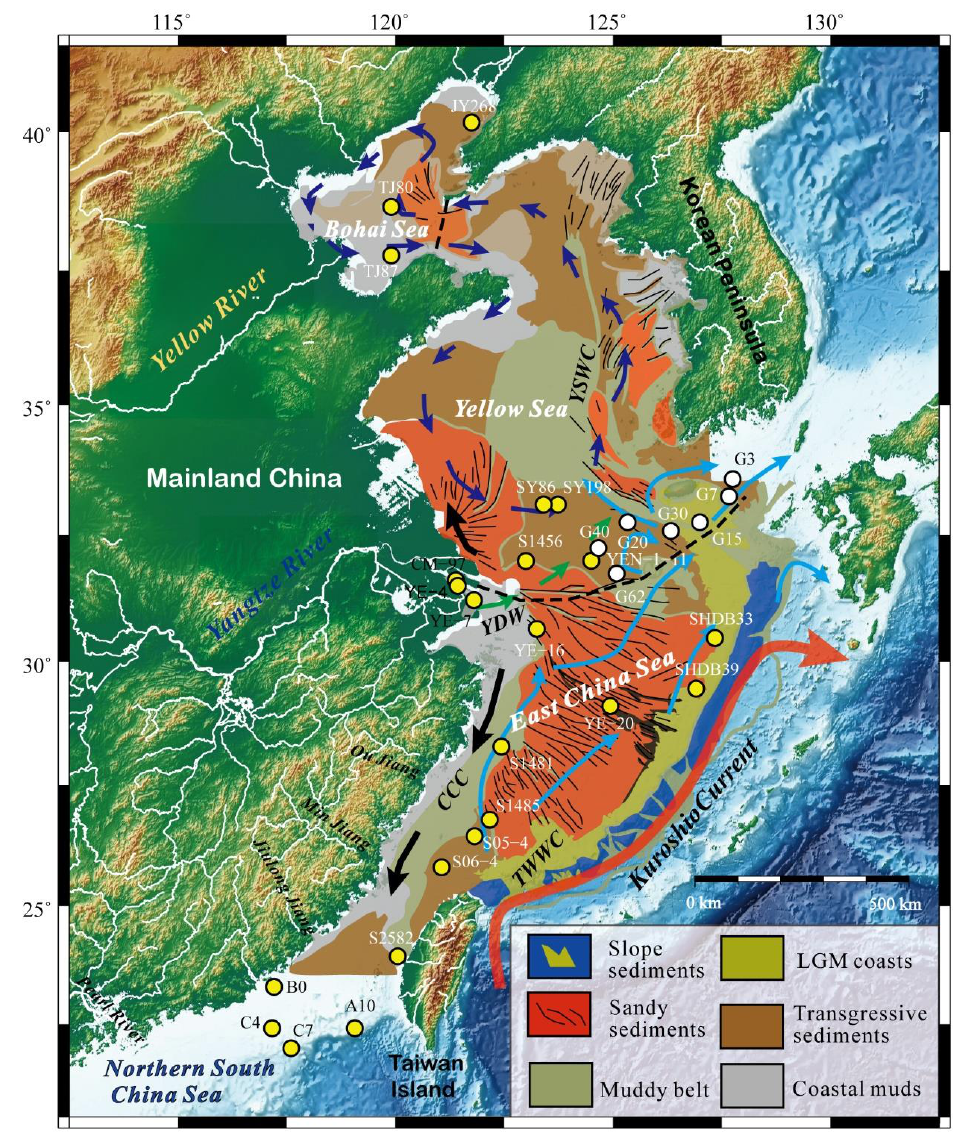
Figure 1. Map showing surface sediment types, ocean currents and sampling sites in the east China seas. The surface sediment distribution and ocean currents are from the literature [30,31], respectively. Ocean currents are denoted by solid lines with different colors (red: Kuroshio Current; light blue: Taiwan Warm Current (TWWC); black: China Coast Current (CCC); green: Yangtze Diluted Water (YDW); dark blue: Yellow Sea Warm Current (YSWC)). Circles filled by yellow are sites analyzed in this study; the ones filled by white are from the literature [32] .